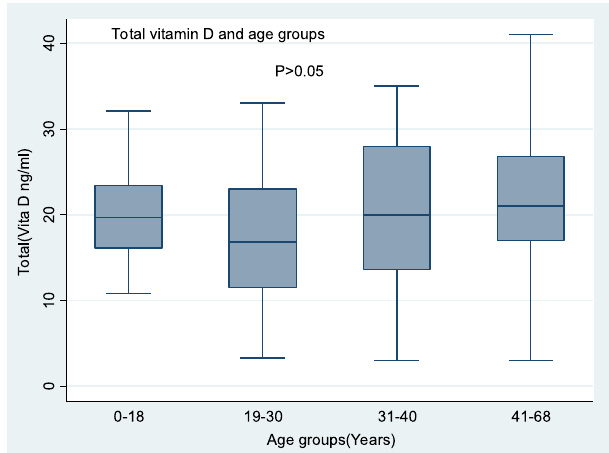
Figure 2. Vitamin D levels and age of active TB patients, LTBI individuals, and those without TB. The boxes represent medians, and the upper and lower ends of the box represent the 75th and 25th percentiles, respectively, while the whiskers are the 5th and 95th percentiles for significance at < 0.05. All ages show deficient and insufficient median levels with no optimal median levels (≥ 30 ng/ml) recorded. The figure was generated using STATA version12, https:// www. stata. com by M.B.